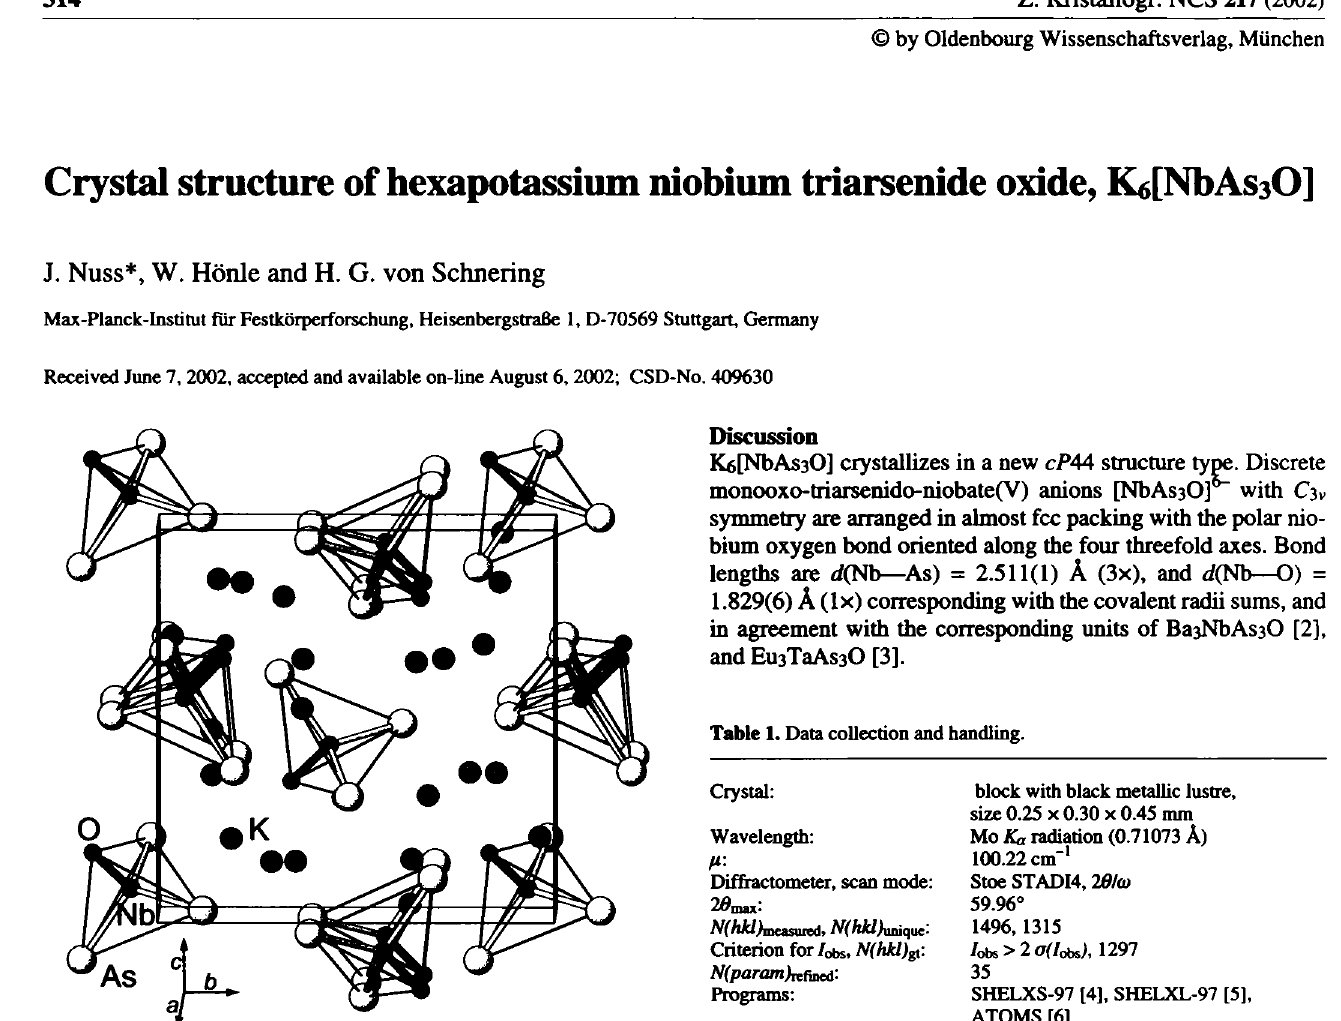
Table 1. Data collection and handling. Crystal: block with black metallic lustre, Crystal: